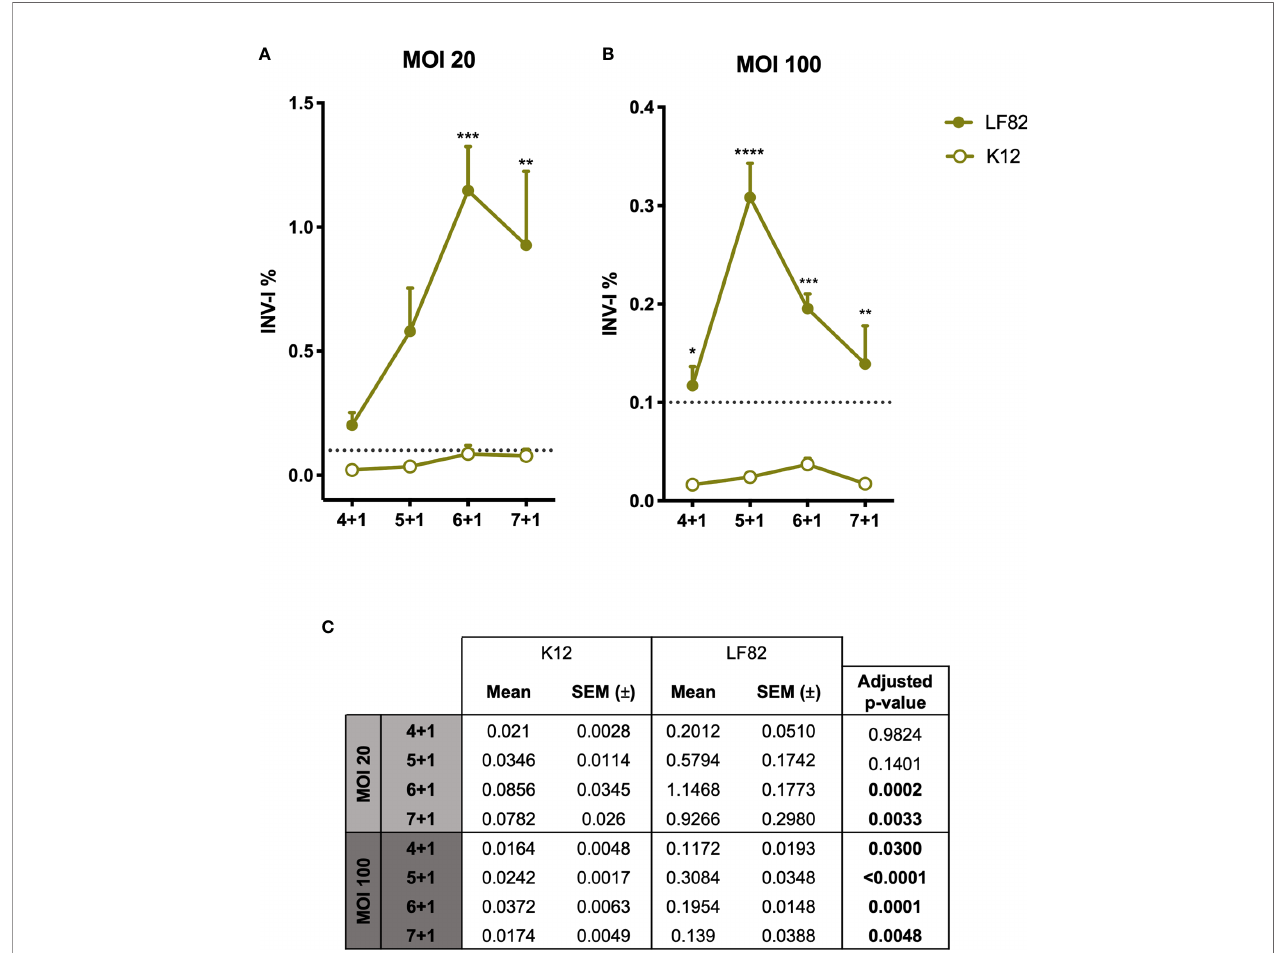
FIGURE 3 | Graphic representation of E . coli LF82 and K12 invasion indexes on d-ODMs. INV-I% of both E . coli strains (n = 5 for each represented point in the graph) at MOI 20 (A) and 100 (B) relative to the increasing infection time points. The dashed line represents the established threshold (0,1) over which E . coli strains were considered to be invasive. The error bars correspond to the SEM. (C) Mean, SEM and adjusted p-values obtained by a 2-way ANOVA test to examine statistical signi fi cance between LF82 and K12 INV-I% for each infection timepoint. This analysis was followed by a Tukey test correction for multiple testing. A P value of <0.05 was considered statistically signi fi cant, and it is highlighted in